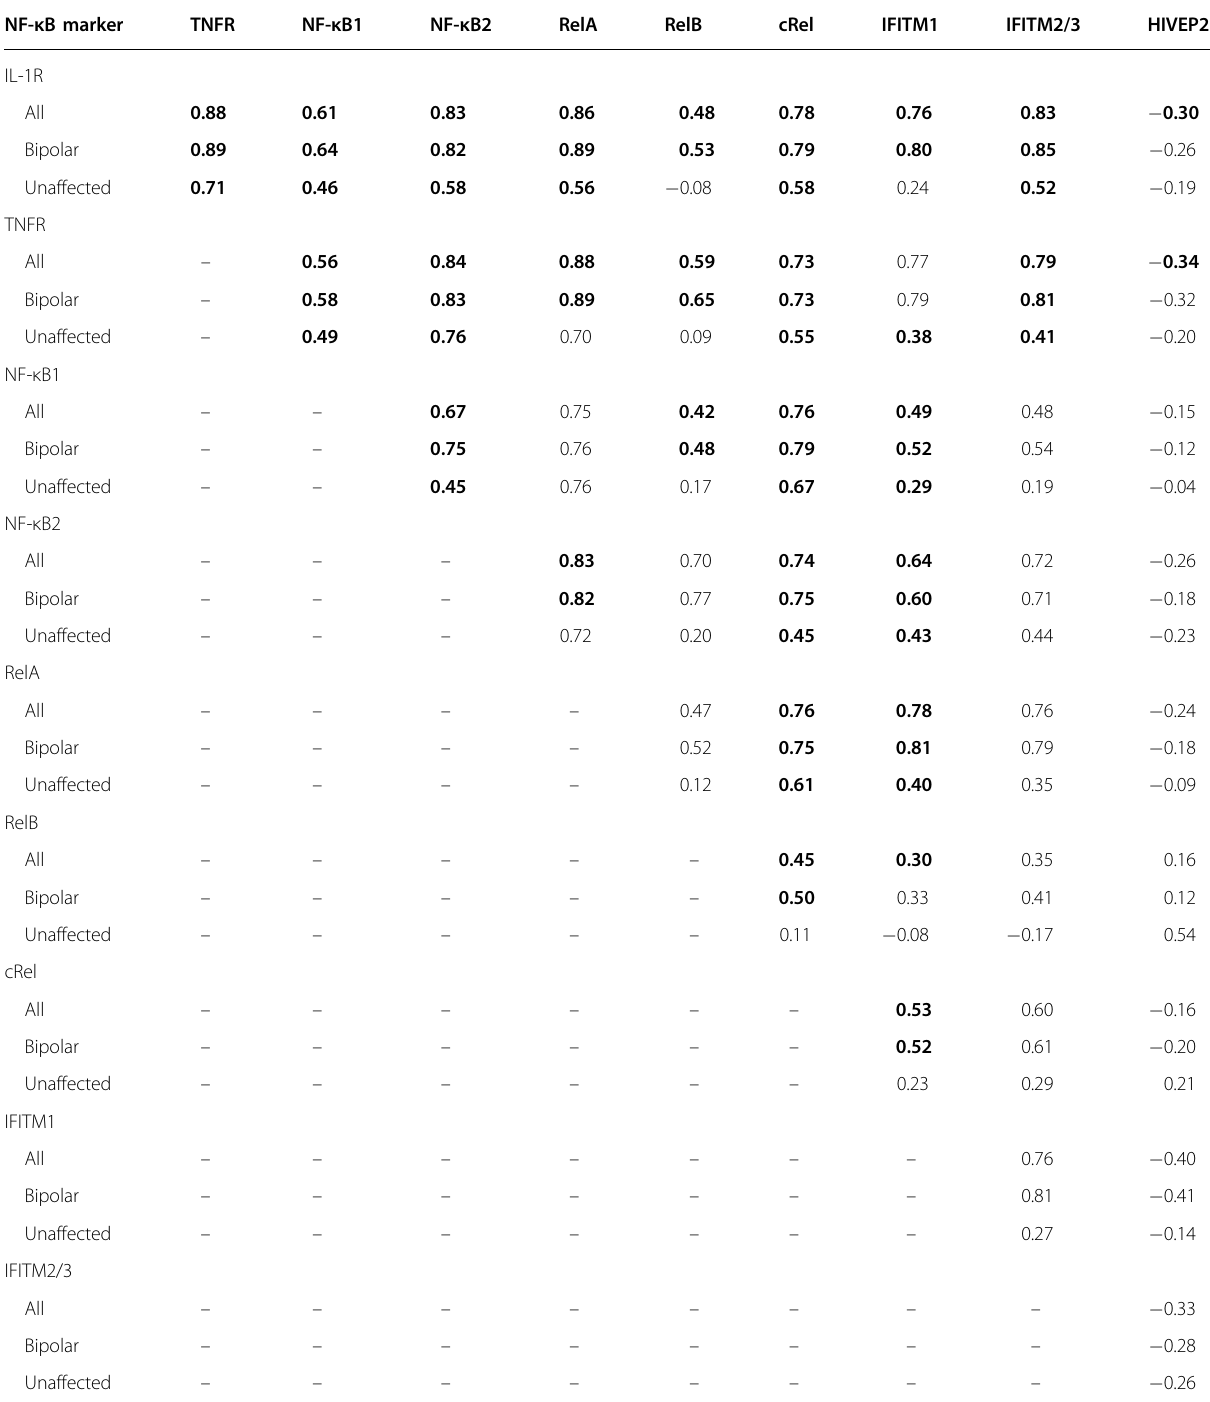
Table 2 Correlations between NF- κ B-related mRNAs in human